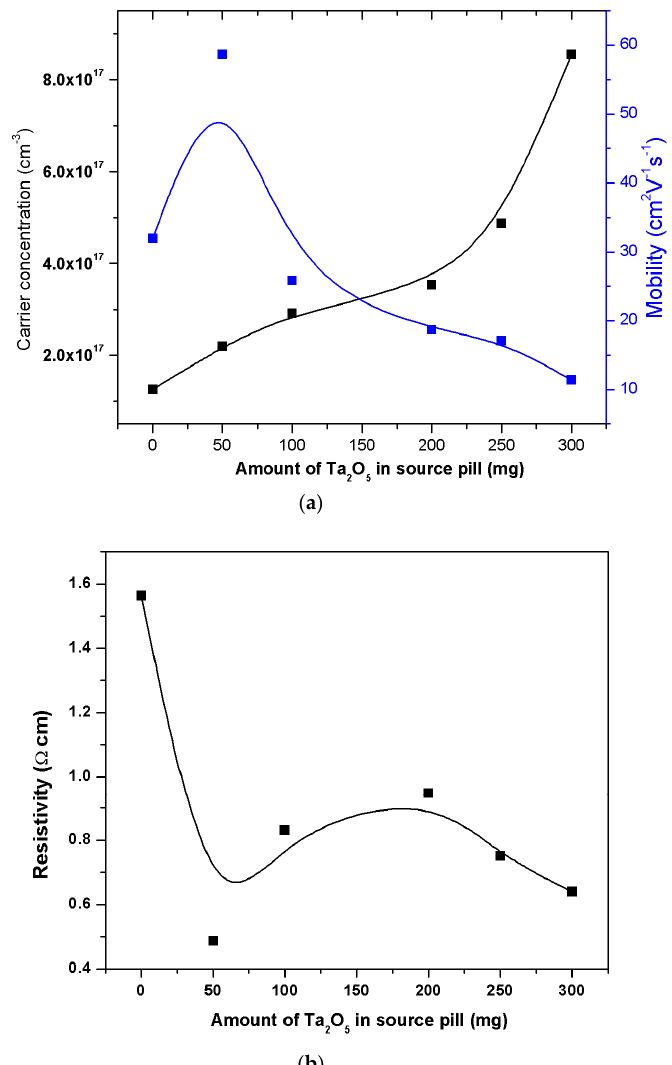
Figure 13. Electrical characterization of ZnO- and ZnO:Ta-doped films: ( a ) carrier concentration and mobility, and ( b ) resistivity.